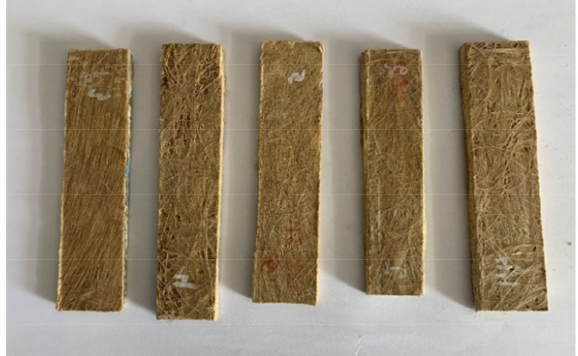
Figure 2. Sisal and Caryota fiber hybrid composites.